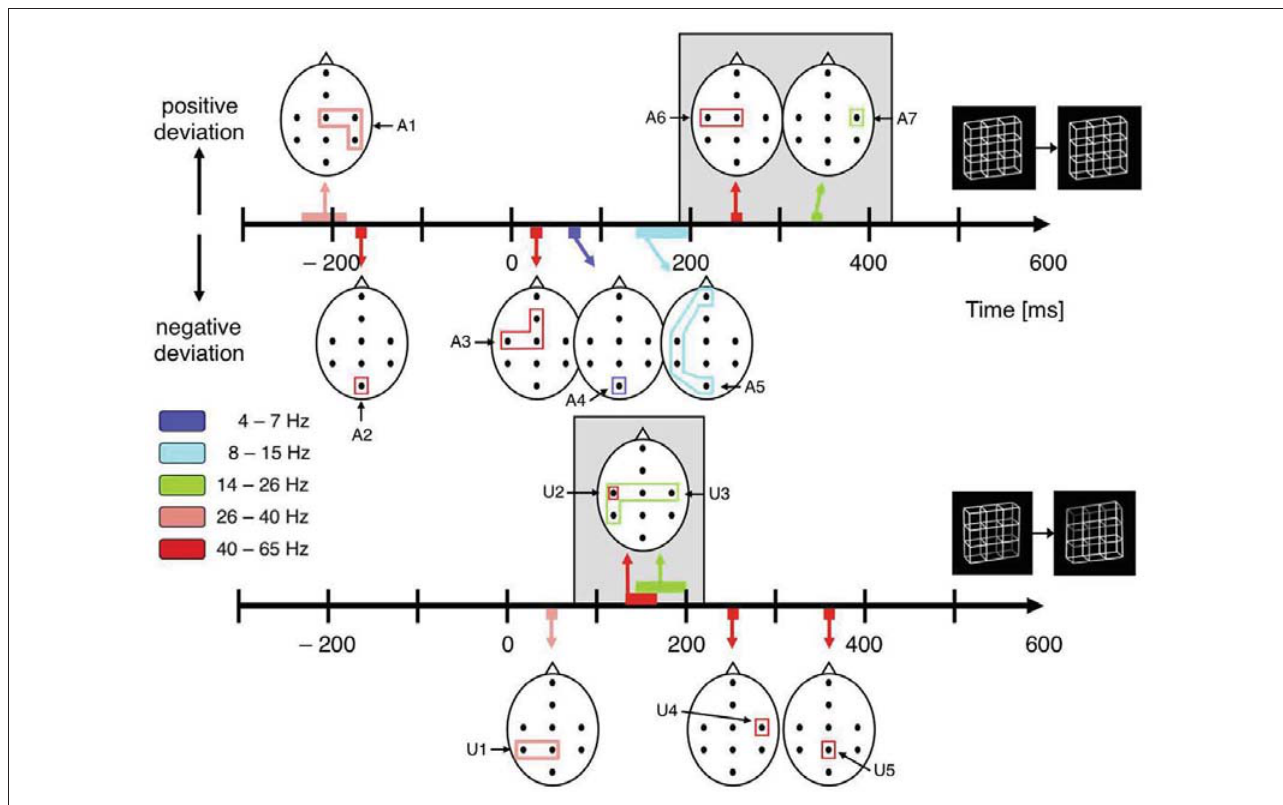
(negative) excursions appear above (below) the time axes.Top: Necker stimulus; bottom: unambiguous stimulus. Gray backgrounds highlight analogies between ambiguous and unambiguous stimuli.Their temporal difference is consistent with dERP results. Pre-onset gamma modulations (A1 and A2) are restricted to the Necker